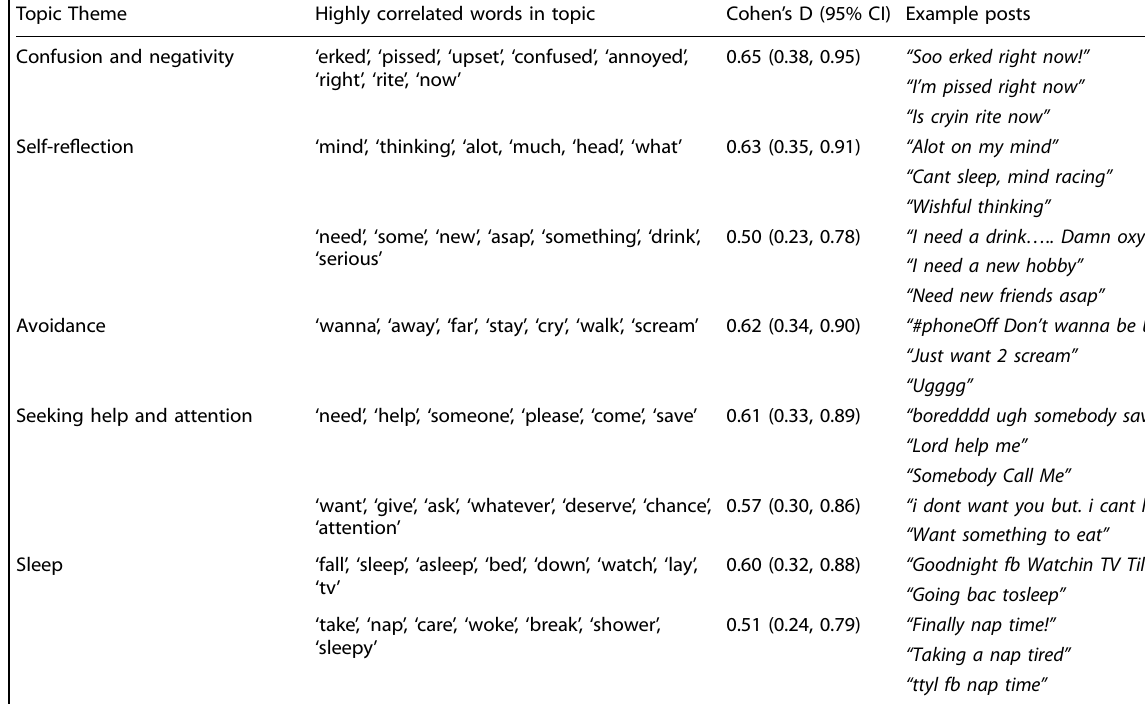
Table 3. Topics (clusters of co-occurring words) signi fi cantly associated with language used in Facebook posts of healthcare super-utilizers. Topic